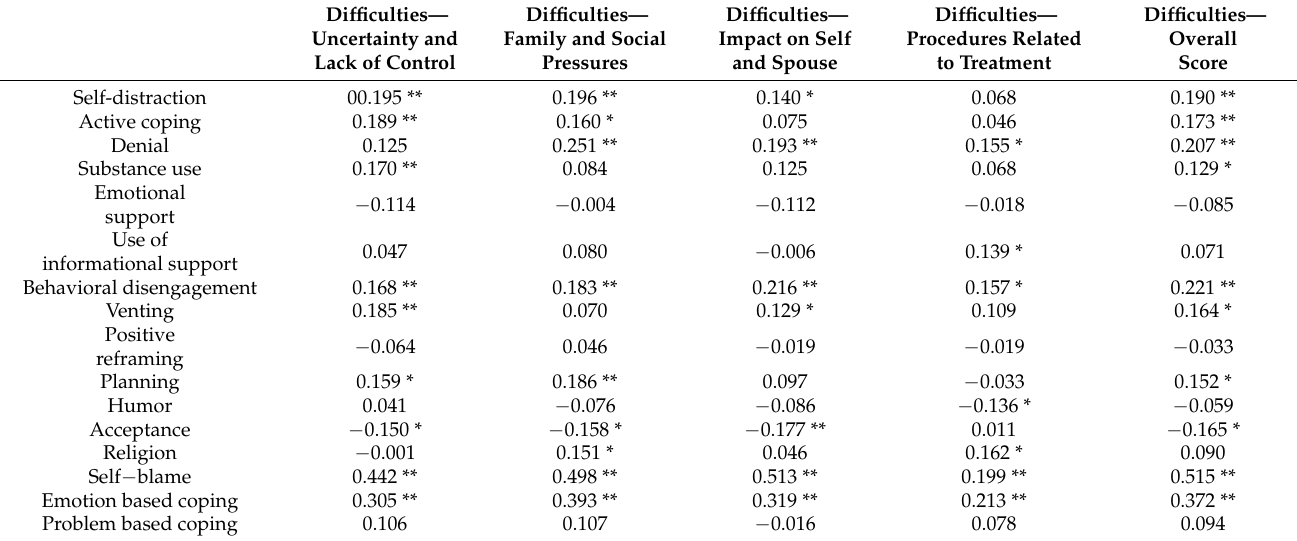
Table 3. Correlations between coping strategies and difficulties of infertile women. Difficulties— Uncertainty and Lack of Control